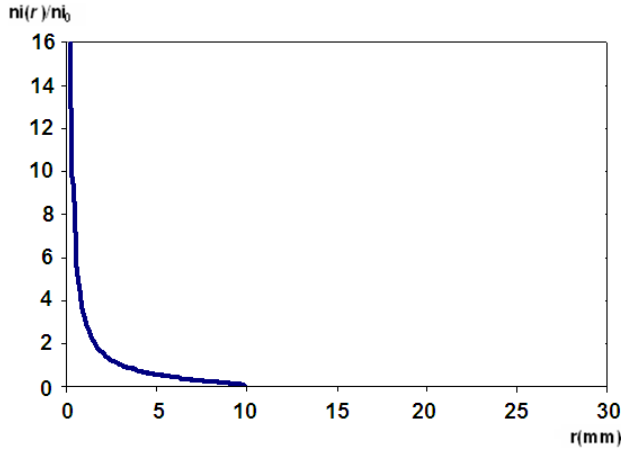
(cid:1) distribution 2